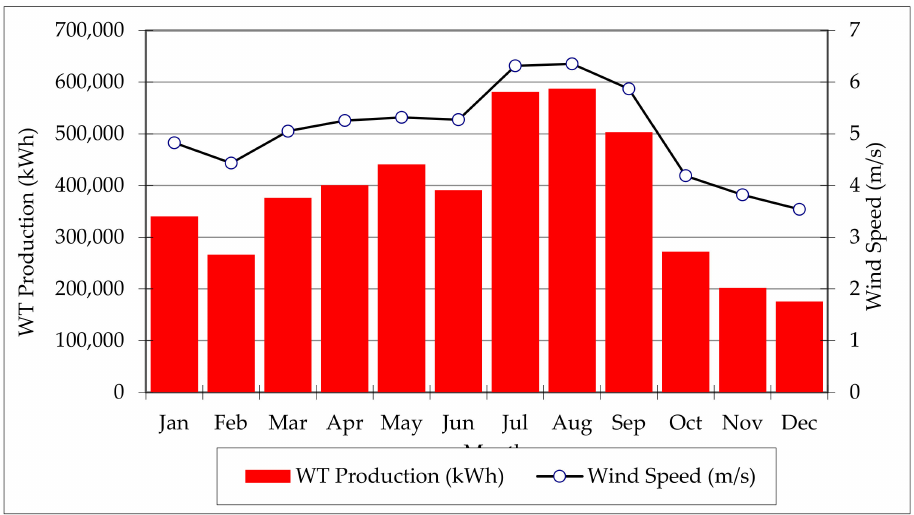
Figure 9. Mean wind speed per month after